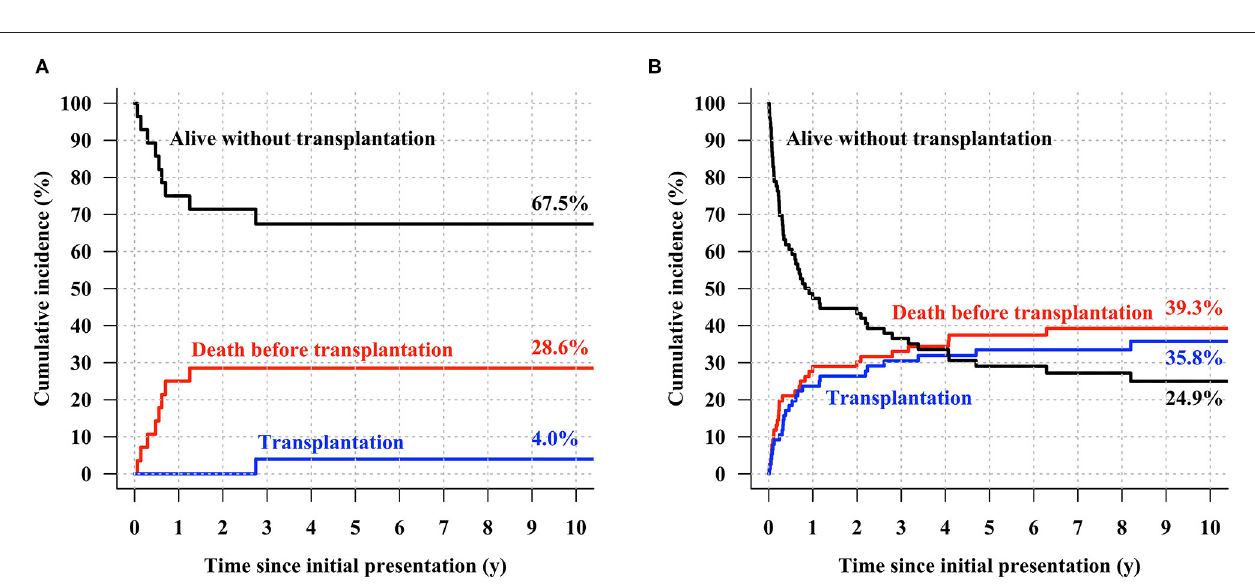
FIGURE 7 | Observed events after stratification into risk groups according to the calculated probability. CE, cardiac event; FR, functional recovery.